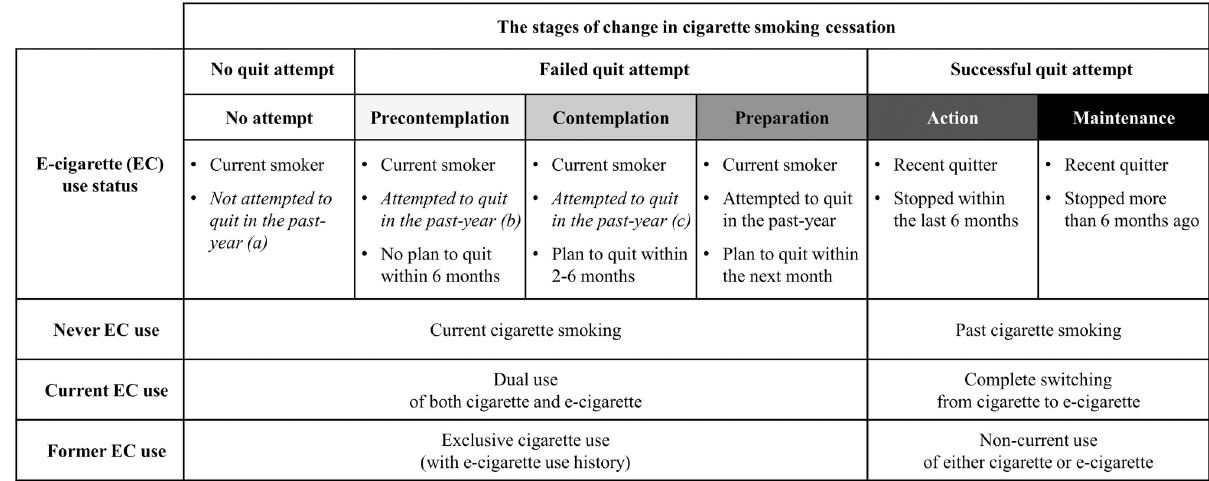
Fig 1. Modified � stages of change model in smoking cessation linked with e-cigarette use status. � Modification (in italics ) from the original model was made by excluding those with no attempt (a) from the ‘Precontemplation’ and ‘Contemplation’ stages, leaving only those with failed quit attempt in these two stages (b and c). Stages are shaded darker for more progressed cessation